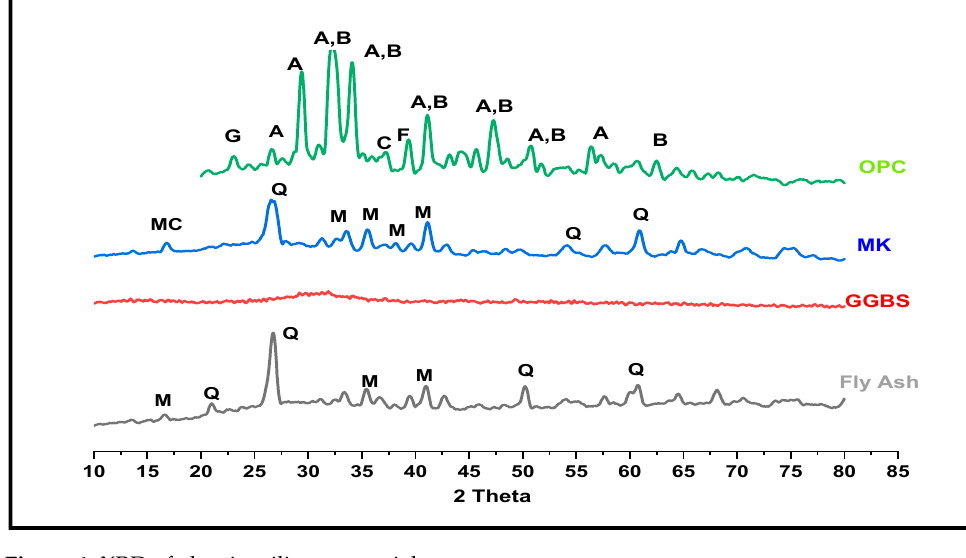
Figure 4. XRD of aluminosilicate materials.